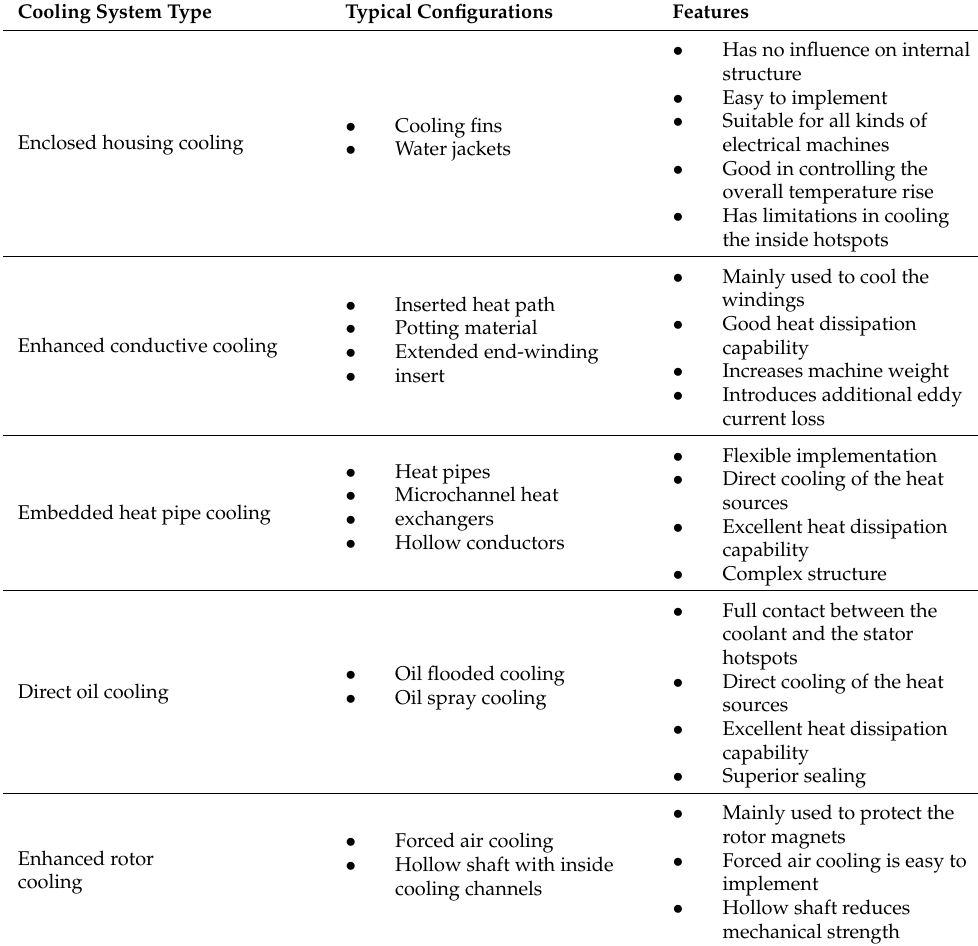
Table 1. Comparison of different cooling